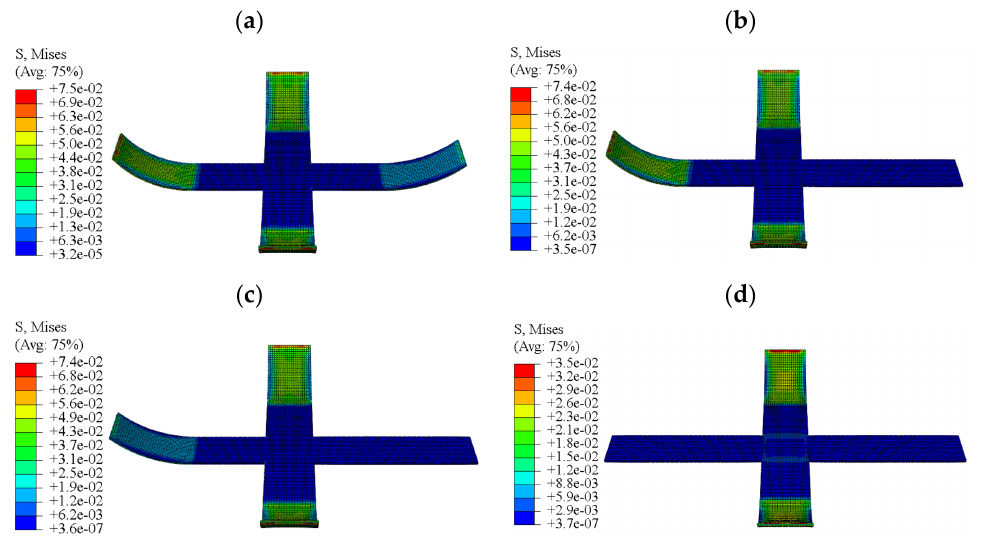
Figure 26. Response stress diagram of the F-DS with step recovery drive: ( a ) stress cloud map showing A-1 being driven; ( b ) stress cloud map showing A-1 being driven to completion; ( c ) stress cloud map showing A-3 being driven; ( d ) stress cloud map showing A-2 and A-4 being driven.